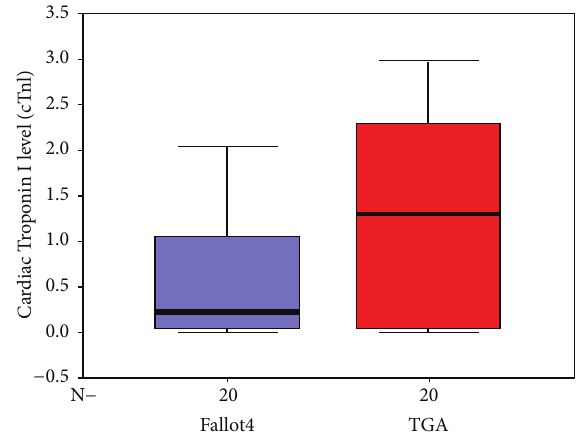
Figure 2: Box-plot shows cTnI levels in the TOF and TGA patients. The bars represent the median and the 5th, 25th, 75th, and 95th